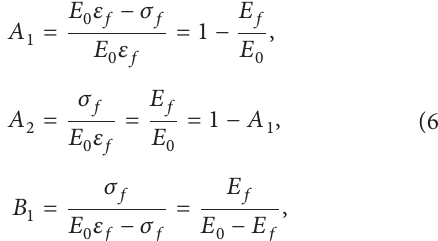
the peak tensile stress. The residual tensile strength is defined as 𝜎 𝑟 = 𝜆𝜎 𝑓 , 𝜆 being the residual strength coefficient, ranging from 0 to 1. Accordingly, the residual strain is defined as = 𝜂𝜀 𝜂 is the residual strain coefficient. Ultimate 𝜀 𝑟 𝑓 , where strain is defined as 𝜀 𝑢 = 𝜉𝜀 𝑓 , where 𝜉 is the ultimate strain